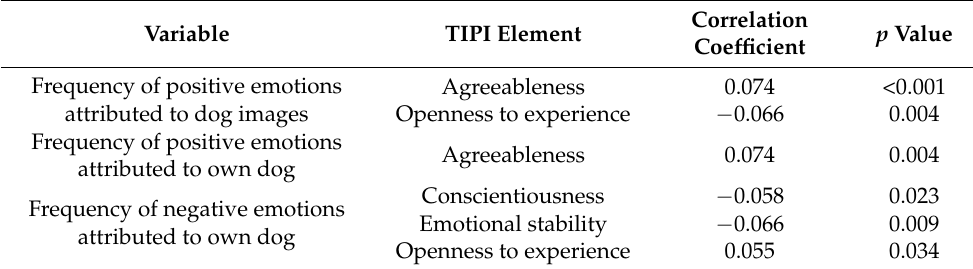
Table 2. Spearman’s rank correlation coefficient analyses between TIPI subscale scores and emotional attribution to dog images and owned dogs summary of significant